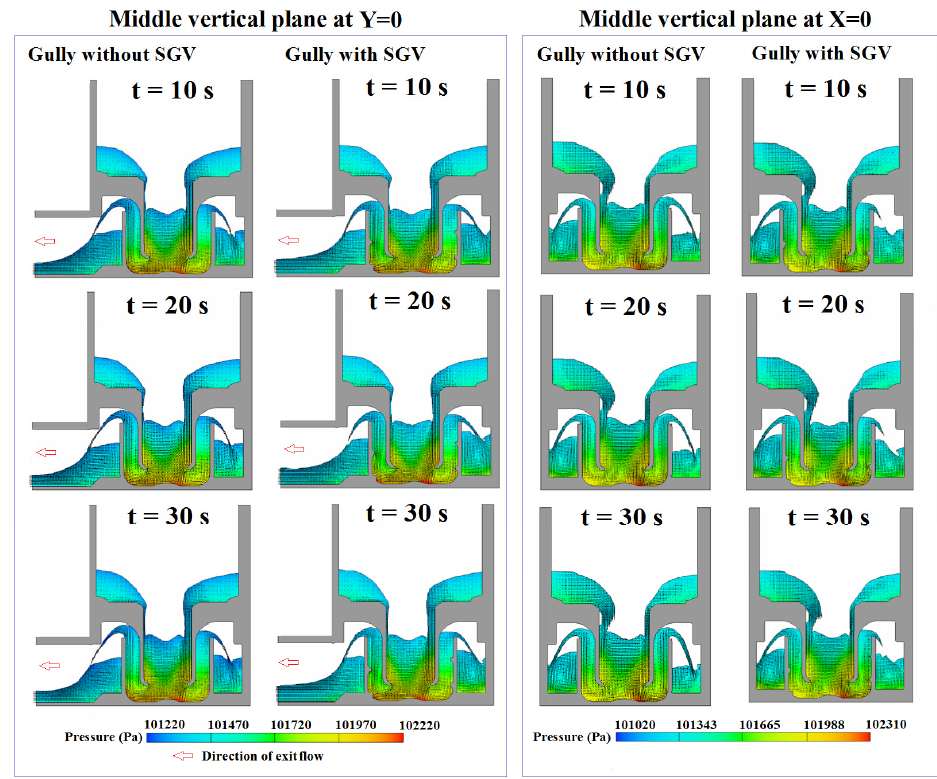
Figure 3. Distributions of instant fluid velocity and pressure over middle vertical planes of Y = 0 and X = 0 at t = 10, 20 and 30 s with Q 1 = Q 2 = 15 L/min.